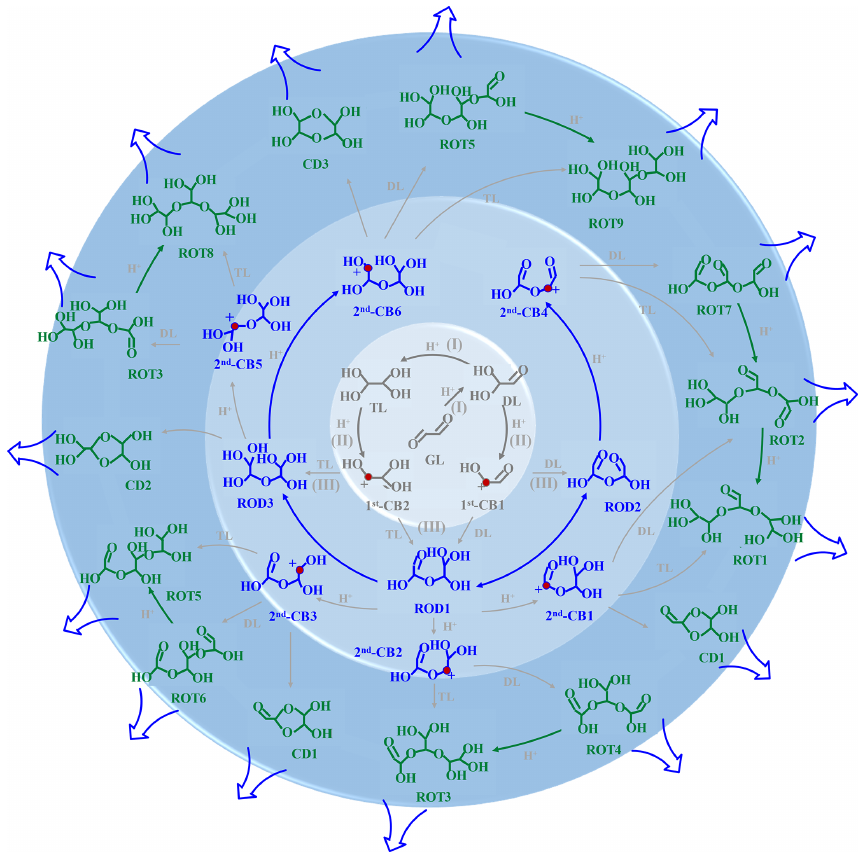
Figure 5. Schematic diagram of formation and propagation of oligomers in the absence of MA / AM. The inside circle ring represents the ion-mediated initial reaction of GL to yield DL, TL, and 1st-CBs; the middle circle ring corresponds to the formation of RODs and 2nd-CBs; the outer circle ring denotes the formation and propagation of ROTs from the association reactions of 2nd-CBs with DL / TL.